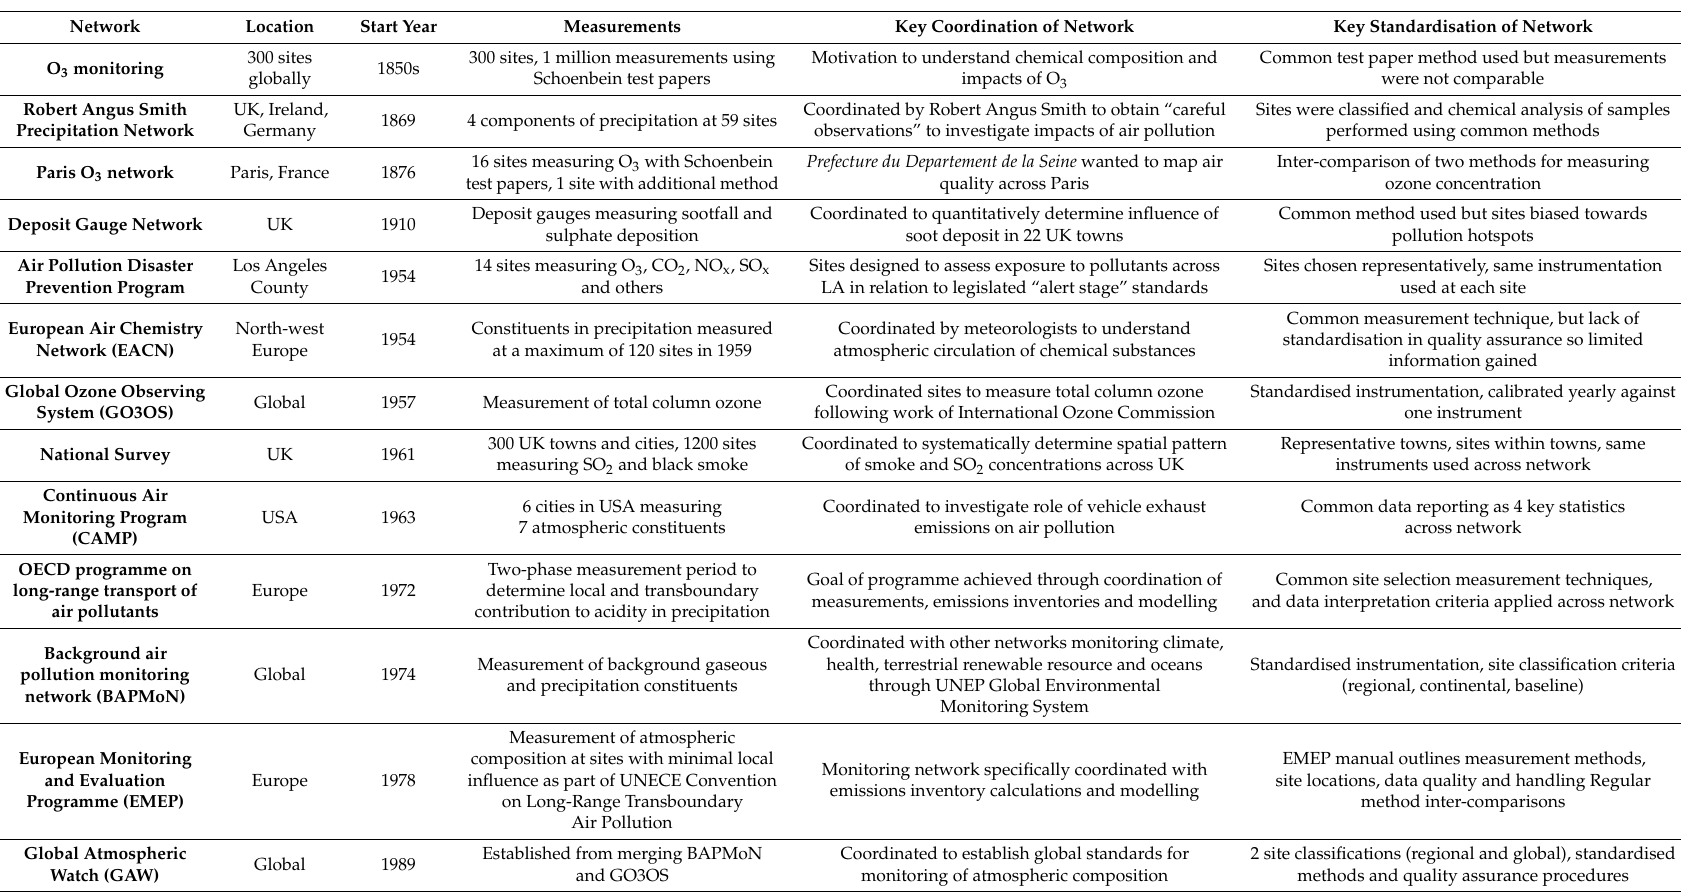
Table 1. Summary of developments in coordination and standardisation implemented in seminal city, national, regional and global ground-level atmospheric composition monitoring